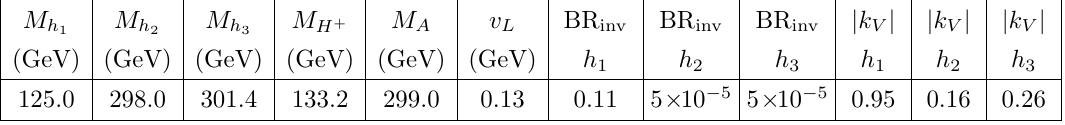
Table 4 . Parameters for point P1.